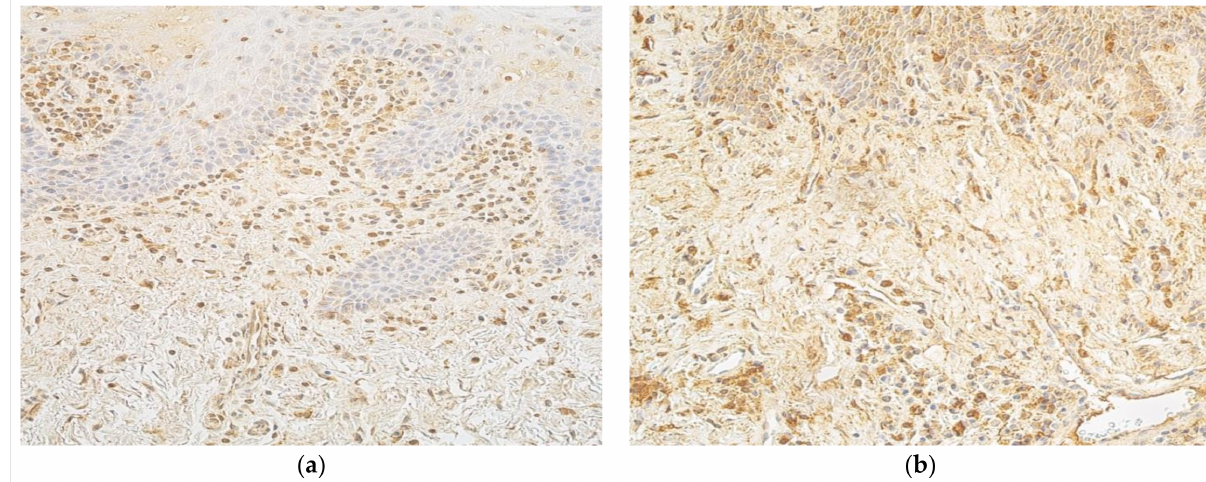
Figure 5. Immunohistochemical micrographs of TNF- α in a cleft affected lip tissue and in control subjects. ( a ) Numerous positive cells (+++) of TNF- α in the connective tissue of a 13 months old child with a cleft lip and palate. TNF- α IMH, × 250; ( b ) Moderate positive cells (++) of TNF- α in the control group tissue sample of a five years old child. TNF- α IMH, × 250.